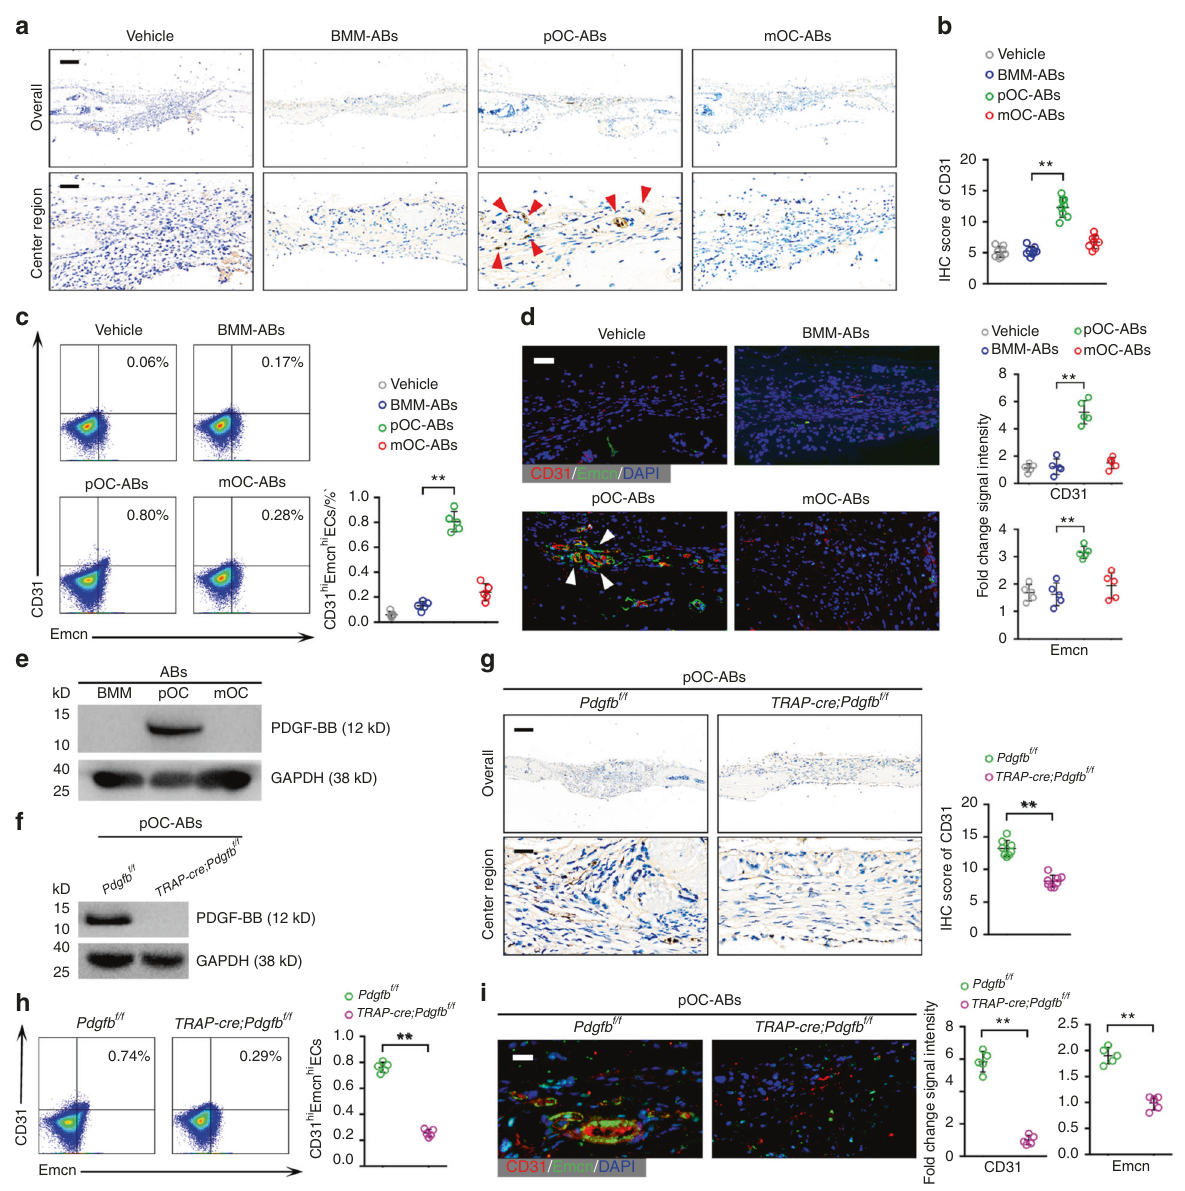
Fig. 5 pOC-ABs promote angiogenesis by delivering PDGF-BB to recipient EPCs. a IHC of CD31 in mice 2 weeks after engrafting of AB-DBM. The red arrows indicate new CD31-positive vessels formed in the DRA. The bars represent 1 mm (upper) and 100 μ m (lower). b Semiquantitative analysis showing the IHC score for CD31 in mice grafted with AB-DBM, n = 8. c Representative fl ow cytometric analysis with the percentages of CD31 hi Emcn hi cells among total cells digested from the DRA, n = 5. d Immunostaining analysis of CD31 and Emcn with quantitative analysis of the relative immunostaining intensities in the DRA. The bar represents 40 μ m, n = 5. e PDGF-BB expression in different ABs, as determined by western blot analysis. As shown, PDGF-BB was included in the proteomic signature of pOC-ABs. f PDGF-BB expression in pOC-ABs isolated from pOCs of TRAP-cre;Pdgfb f/f mice, as determined by western blot analysis. g IHC and semiquantitative analysis of CD31 expression in mice grafted with DBM preincubated with TRAP-cre;Pdgfb f/f pOC-ABs or Pdgfb f/f pOC-ABs. The bar represents 1 mm in the overview and 100 μ m in the center region, n = 8. h Representative fl ow cytometric analysis with the percentages of CD31 hi Emcn hi cells among total cells digested from the DRA, n = 5. i Representative images of immunostaining of CD31 and Emcn with quanti fi cation of the relative CD31 and Emcn immunostaining intensities in the DRA. The bar represents 20 μ m, n = 5. The data in the fi gures are presented as the average ± SD values. Statistically signi fi cant differences between the treatment and control groups are indicated as * ( P < 0.05) or ** ( P <